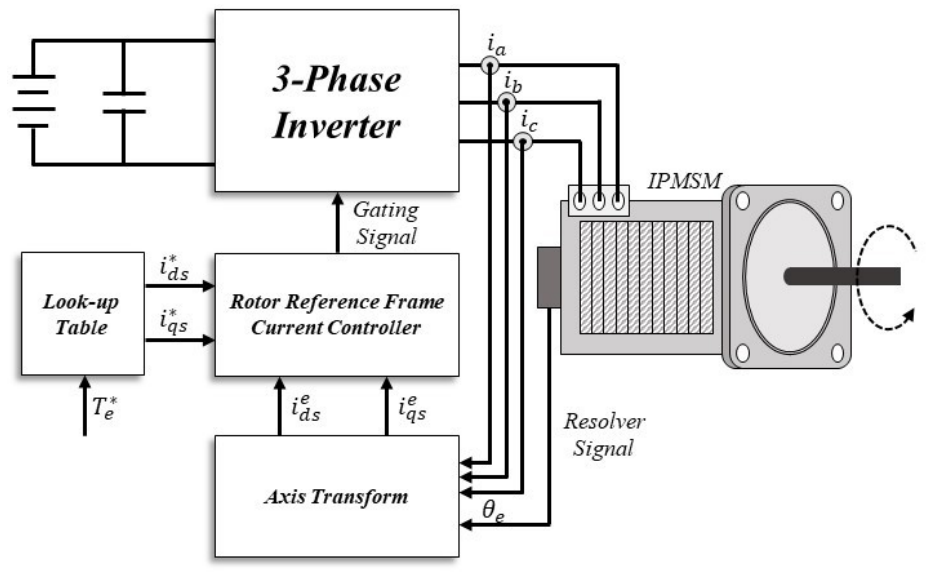
Figure 4. Torque control system of IPMSM.